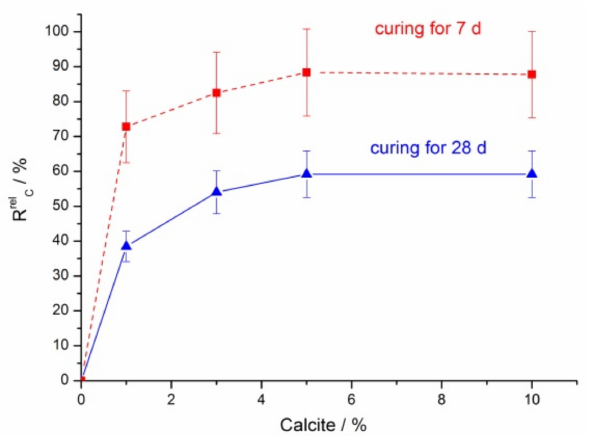
Figure 6. Relative increment of calcite addition in the strength of geopolymers (R rel C ) based on the FA + calcite blends at the age of 7 and 28 days (calculated using data from [38]).